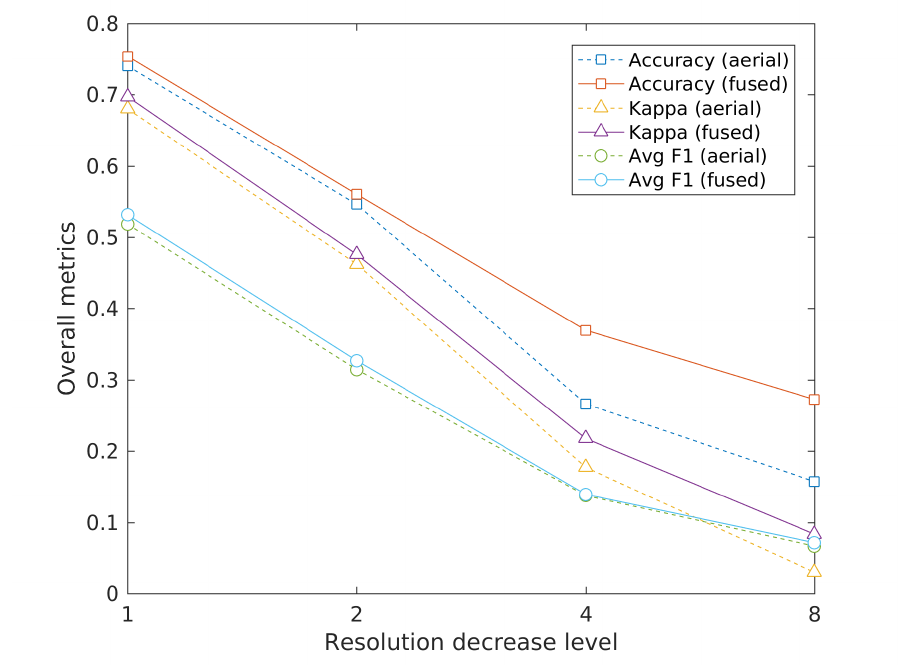
Figure 10. Evaluation results of different aerial image